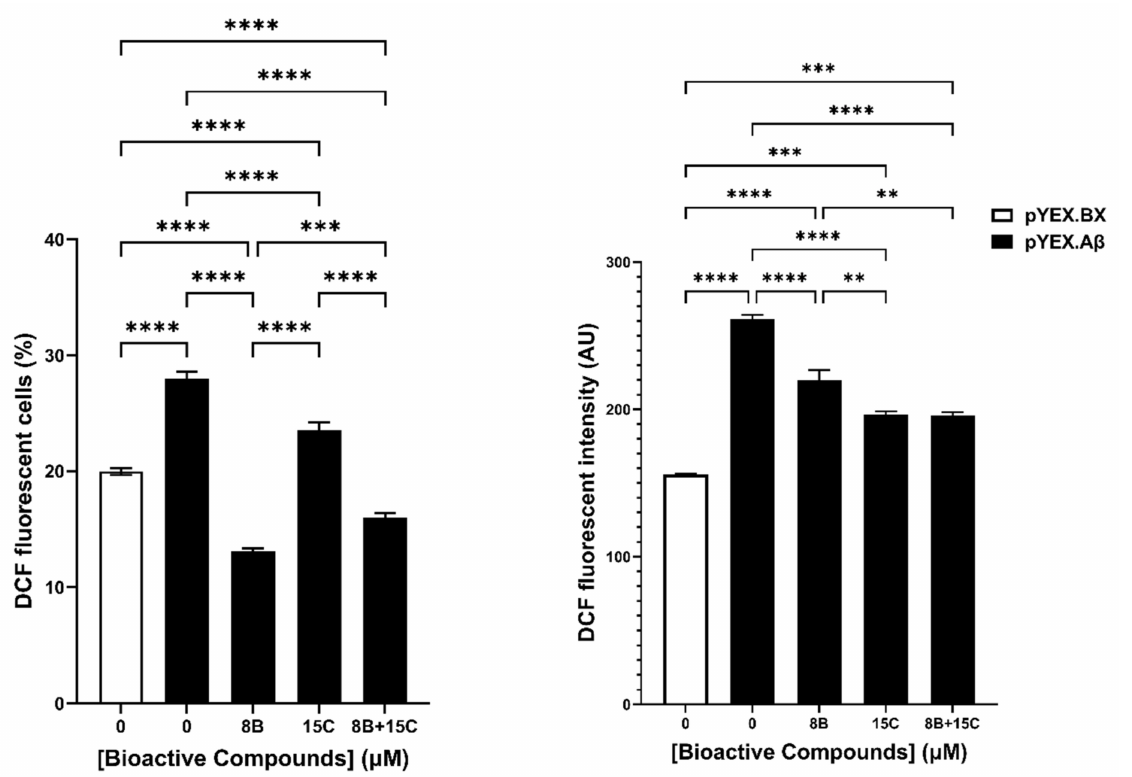
Figure 6. Effect on intracellular reactive oxygen species (ROS) in BY4743 [pYEX.A β ] cells treated with 8 µ M baicalein (8B), 15 µ M trans -chalcone (15C) and their combination (8B + 15C). pYEX.BX represents data obtained from BY4743 [pYEX.BX] empty vector control and pYEX.A β represents data obtained from BY4743 [pYEX.A β ] transformants. Left panel shows the change in percentage of dichlorofluorescein (DCF) fluorescent cells and right panel shows the median DCF fluorescence intensity differences between the treatments. Statistically significant values obtained by one-way ANOVA analysis are represented by asterisks (** p < 0.01, *** p < 0.001 and **** p <